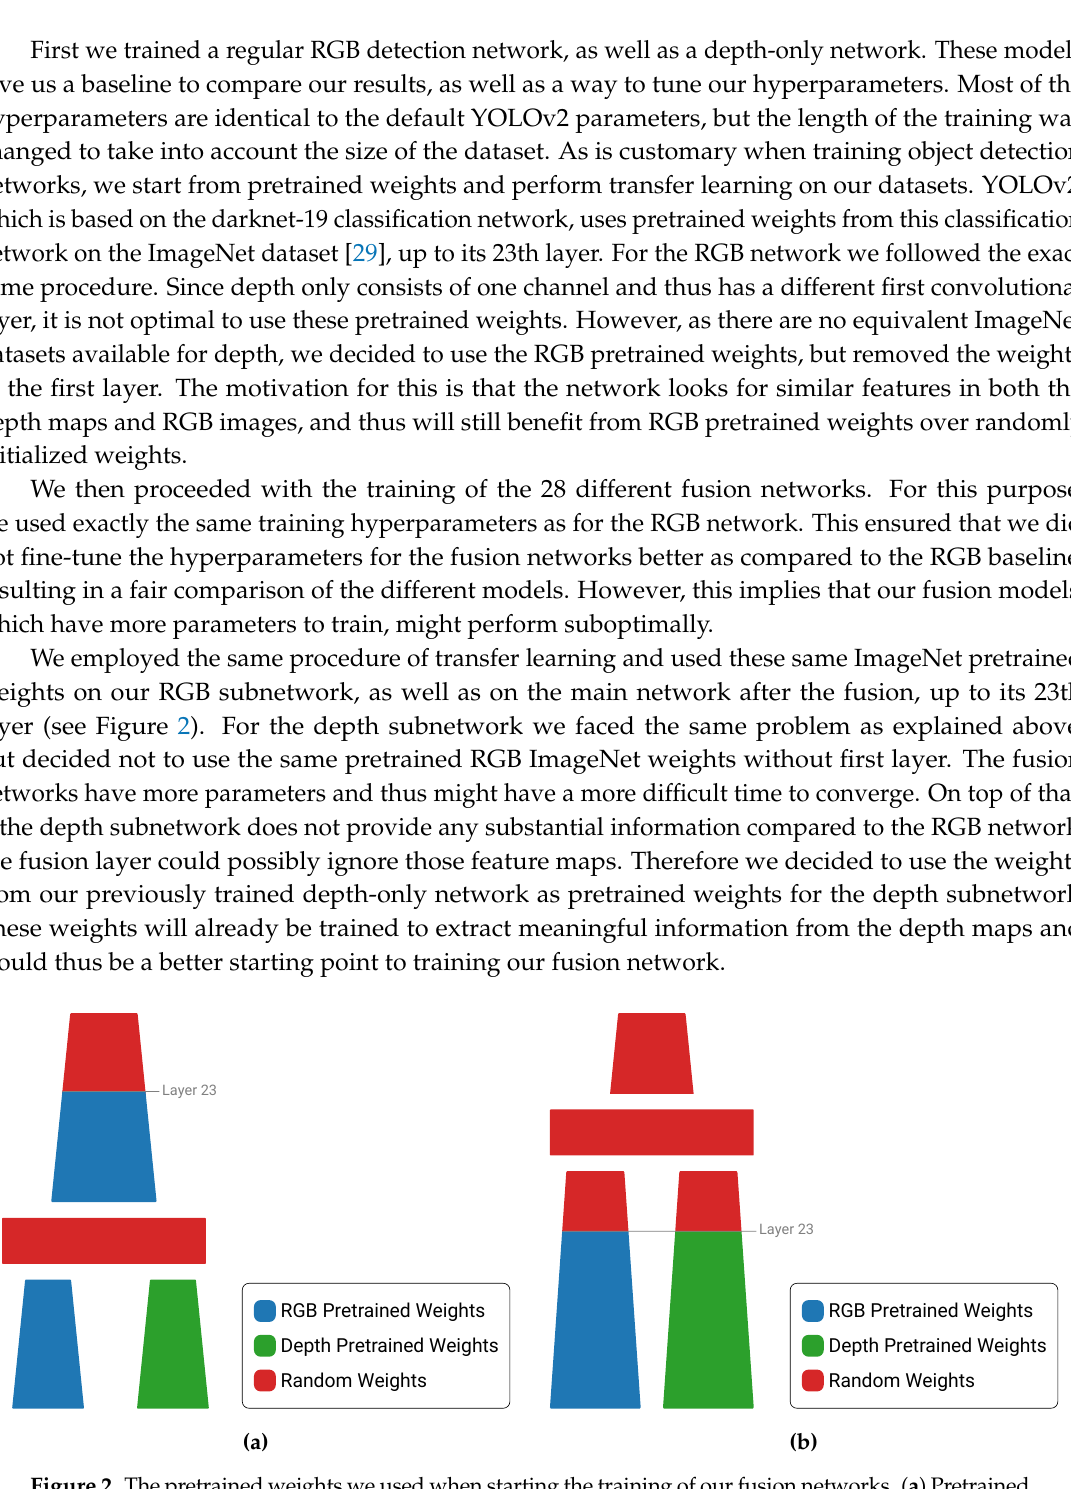
Figure 2. The pretrained weights we used when starting the training of our fusion networks. ( a ) Pretrained weights when fusing before convolutional layer 23. ( b ) Pretrained weights when fusing after convolutional layer